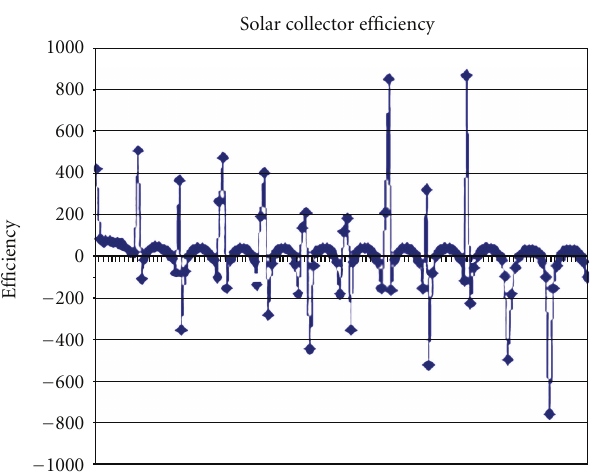
Figure 10: Energy consumption